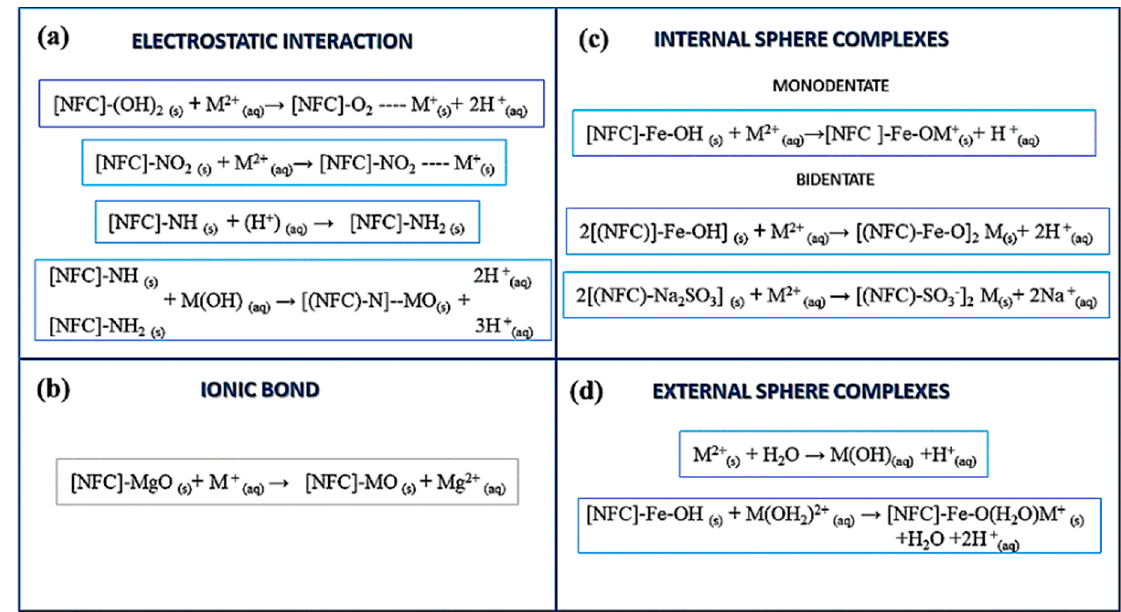
Figure 14. Metal ion (M 2+ ) adsorption mechanisms on composite adsorbent: ( a ) electrostatic interactions, ( b ) ionic bond formation, ( c ) internal sphere complexes formation, ( d ) external sphere complexes formation. [3,56,85,102,103].